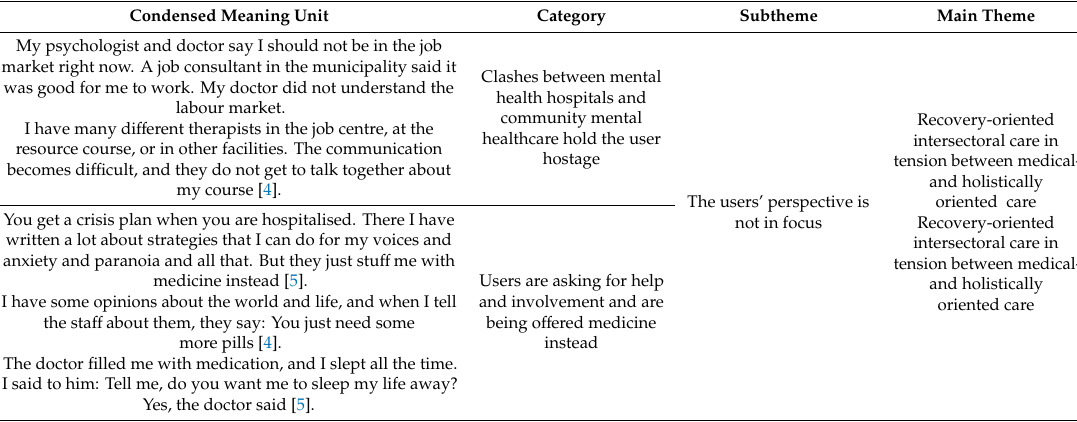
Table 4. Condensed meaning units, categories, subthemes, and themes as perceived by